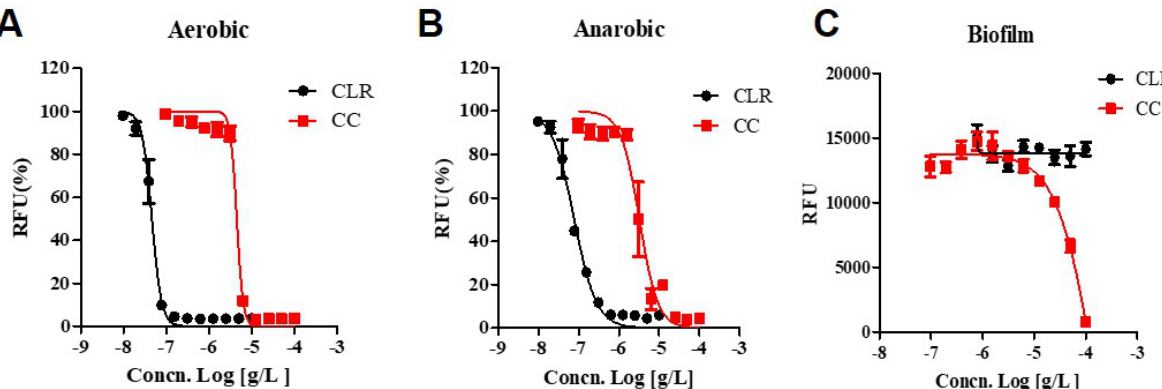
Figure 4. Dose-response curves of CC. Dose-response curves of M. abscessus under aerobic, anaerobic, and biofilm conditions using resazurin. CLR was used as a reference control. ( A ) aerobic condition, M. abscessus was cultured until the mid-log phase, taking approximately 24 h. ( B ) anaerobic condition, M. abscessus was undergone for seven days within an anaerobic generating container system (BD GasPak™EZ). ( C ) Biofilm, M. abscessus was examined with Calgary Biofilm Device. The experiments were carried out with three biological replicates and expressed as the mean ± SEM for each concentration. This result was made from a representative experiment.